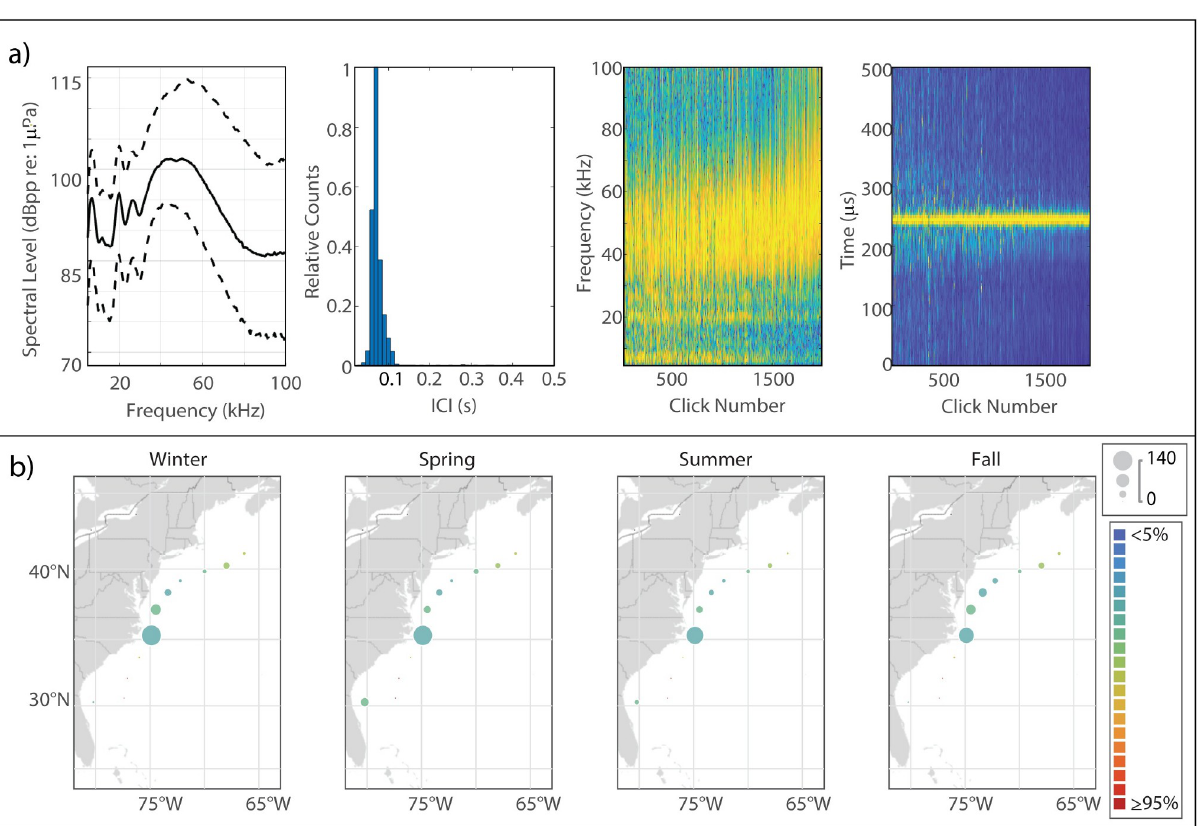
Fig 15. Results for UD47 showing click type (a), and acoustic presence (b). Subplots as in Fig 2a and